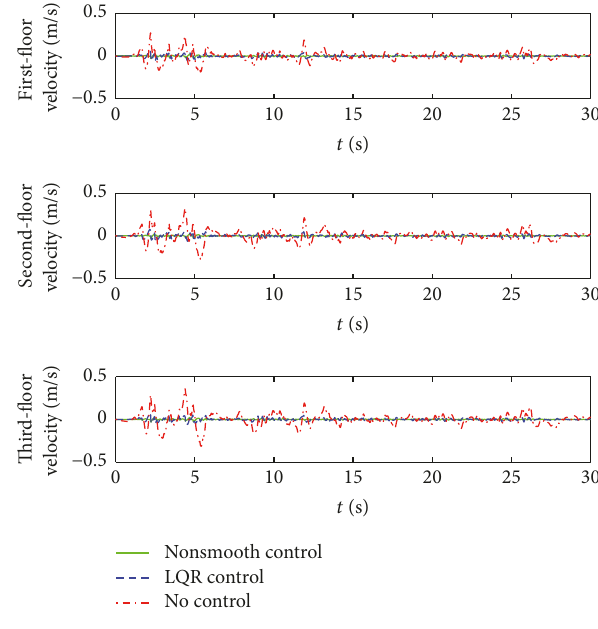
Figure 3: Velocity response of example 1.